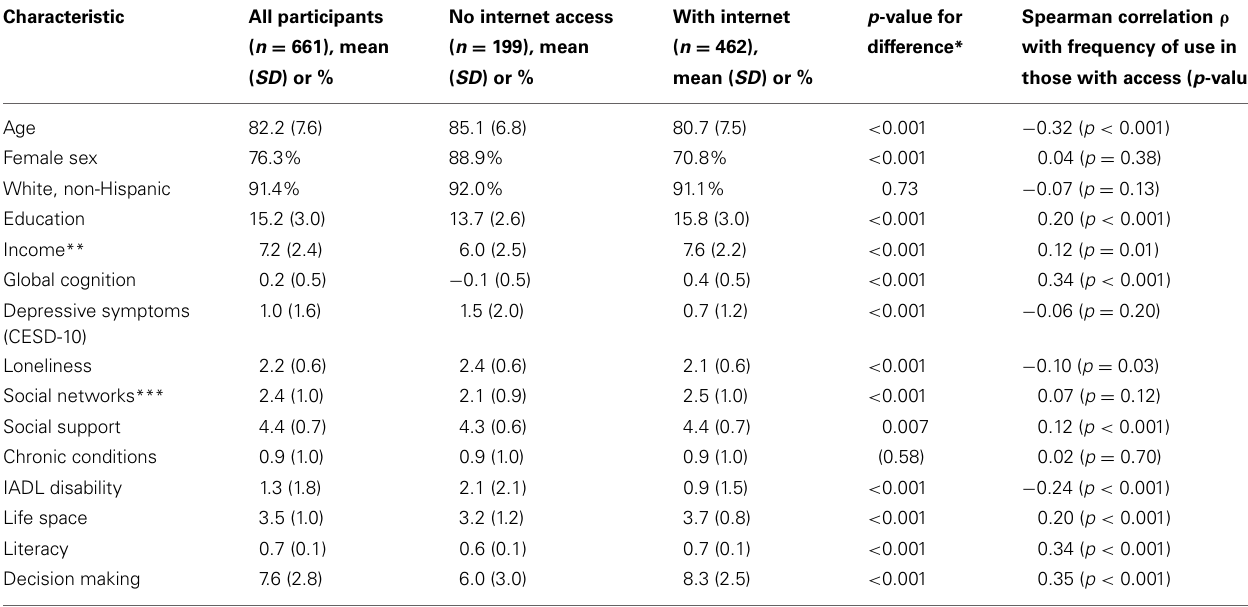
Table 2 | Characteristics of cohort by internet access, and correlations of internet use frequency with characteristics. Characteristic